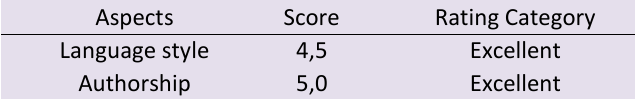
Table 4. Score Results Per Linguist Aspect